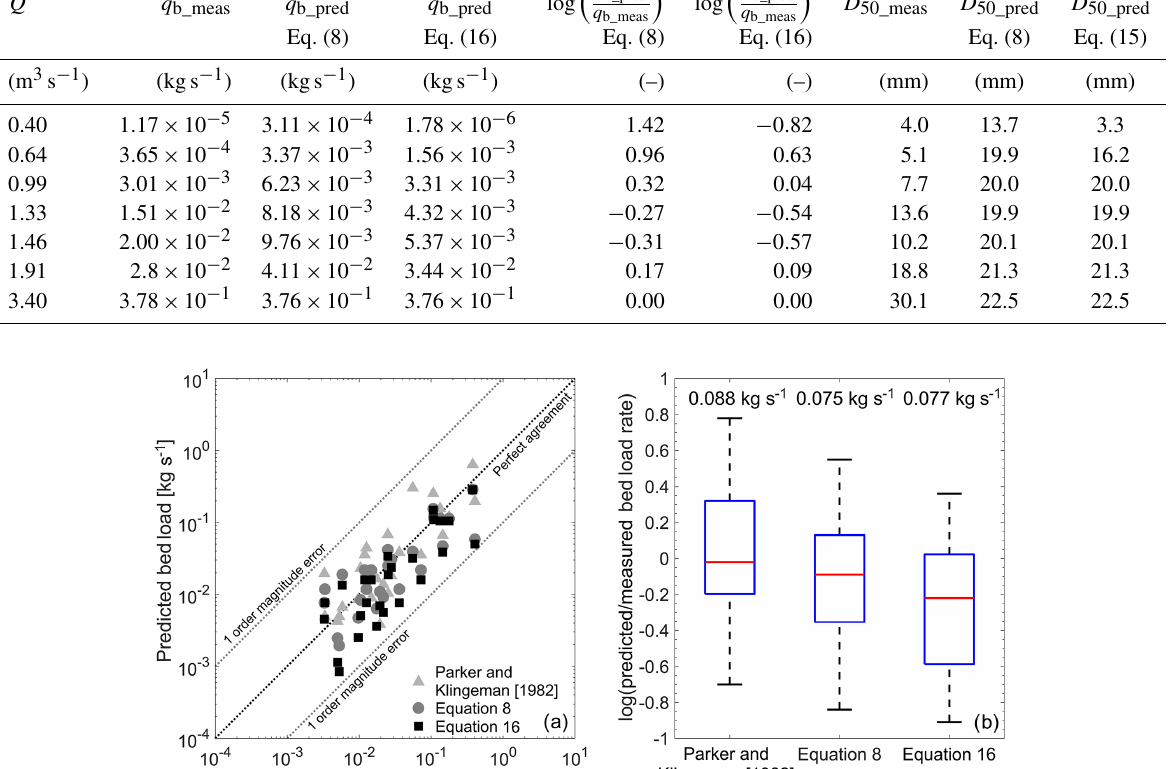
Figure 9. (a) Comparison between measured and predicted bed load transport rate using the Parker and Klingeman (1982) equation and Eqs. (8) and (16). In this case, Parker and Klingeman (1982) was applied as proposed in the original publication (i.e., using reach-averaged flow properties). Equations (8) and (16) use spatial distributions of τ obtained with a gamma function and α and β parameters varying with Q . (b) The log of the ratio of predicted to measured sediment bed load rate for the three approaches. A value of zero indicates that the measured volume was predicted exactly. The top and bottom of each box are the 25th and 75th percentiles, and the middle line inside the box is the median value. Lines extending out of the box correspond to the maximum and minimum predicted bed load ratios. The rate at the top of each box corresponds to the RMSE of the predicted bed load